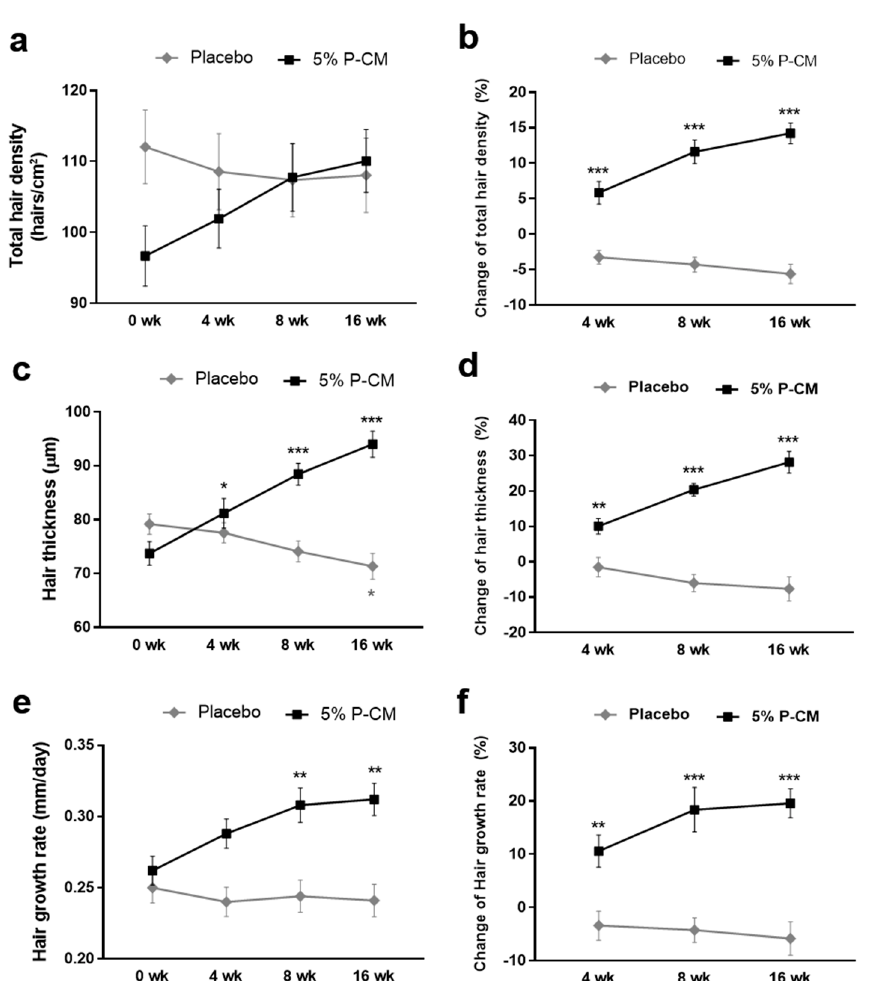
Figure 5. Clinical study of hair growth in participants using P-CM at 4, 8, and 16 weeks. The results of the clinical study suggest that a hair tonic containing 5% P-CM could help to treat androgenetic alopecia. Measurements of the ( a , b ) hair density, ( c , d ) hair thickness, and ( e , f ) hair growth rate showed a significant increase in the 5% P-CM-treated group compared to the placebo group. Statistically significant di ff erences for the ( a ) total hair density, ( c ) hair thickness, and ( e ) hair growth rate were determined between week 0 and 16 of the same group. For the change of the ( b ) hair density, ( d ) hair thickness, and ( f ) hair growth factor, a significant di ff erence of P-CM was determined compared to the placebo group. * p < 0.05, ** p < 0.01, and *** p < 0.001. Abbreviations: P-CM, primed MSC-derived conditioned